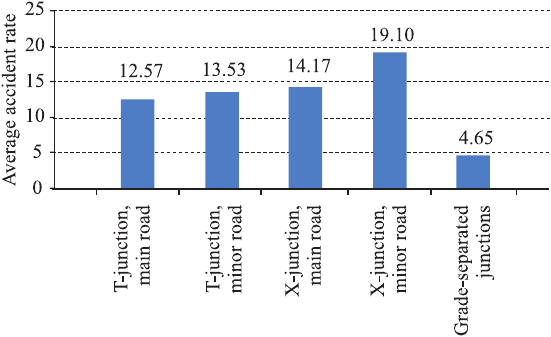
Fig. 4. The average accident rate of the groups of junctions